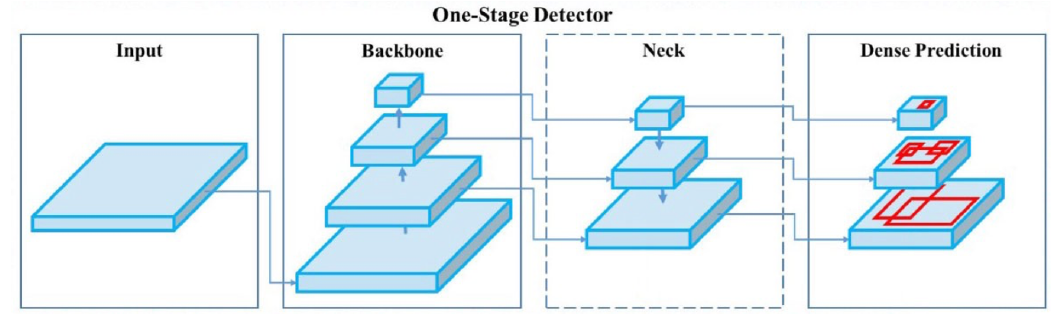
Figure 4. Illustration of design and functionality of the object detection method YOLOv4. Image source of (Bochkovskiy et al.,